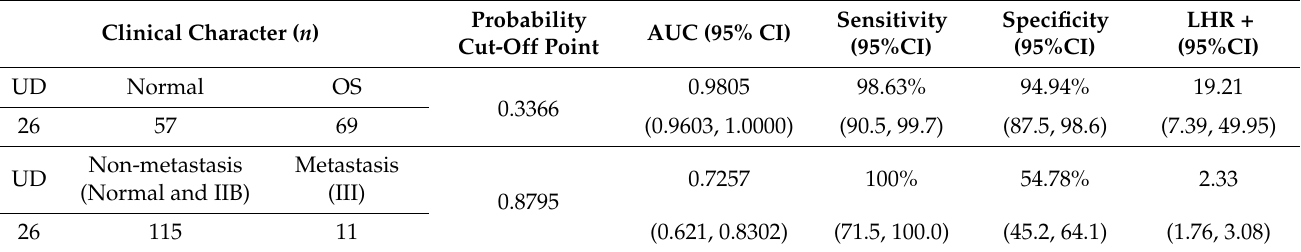
Table 4. Diagnostic and metastatic prediction accuracy ( n = 152).